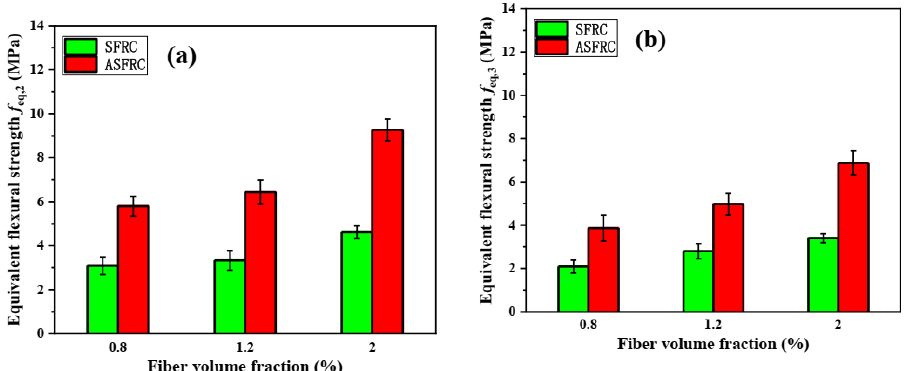
Figure 6. The equivalent flexure strength of SFRC and ASFRC specimens: ( a ) Equivalent flexure strength f eq ,2 and ( b ) Equivalent flexure strength f eq ,3 .